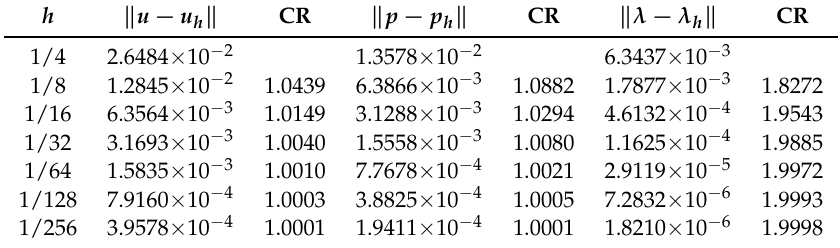
Table 3. Discrete errors and convergence rates for Example 1 at time T = 1 with δ t = 0.1 and nb =